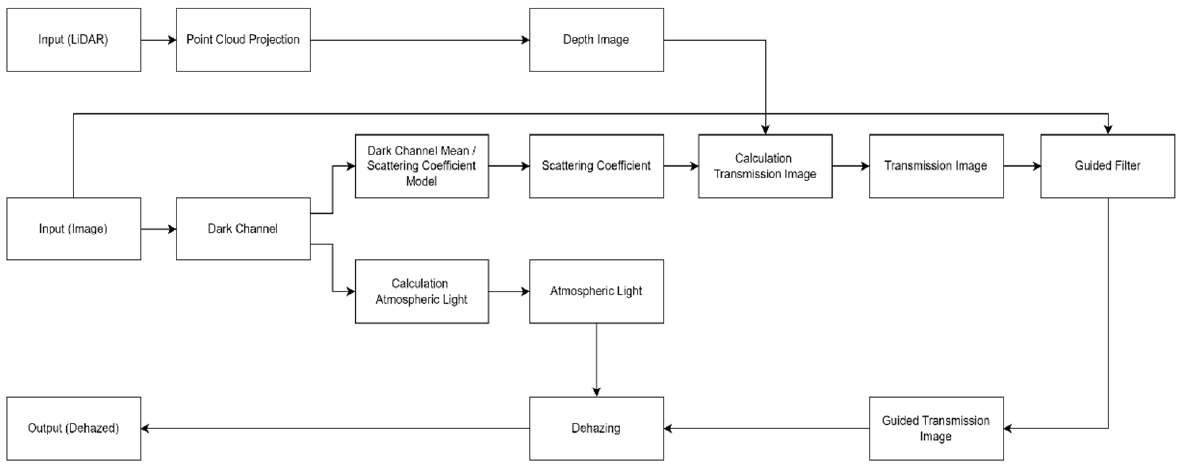
Figure 3. Flowchart of the proposed method.